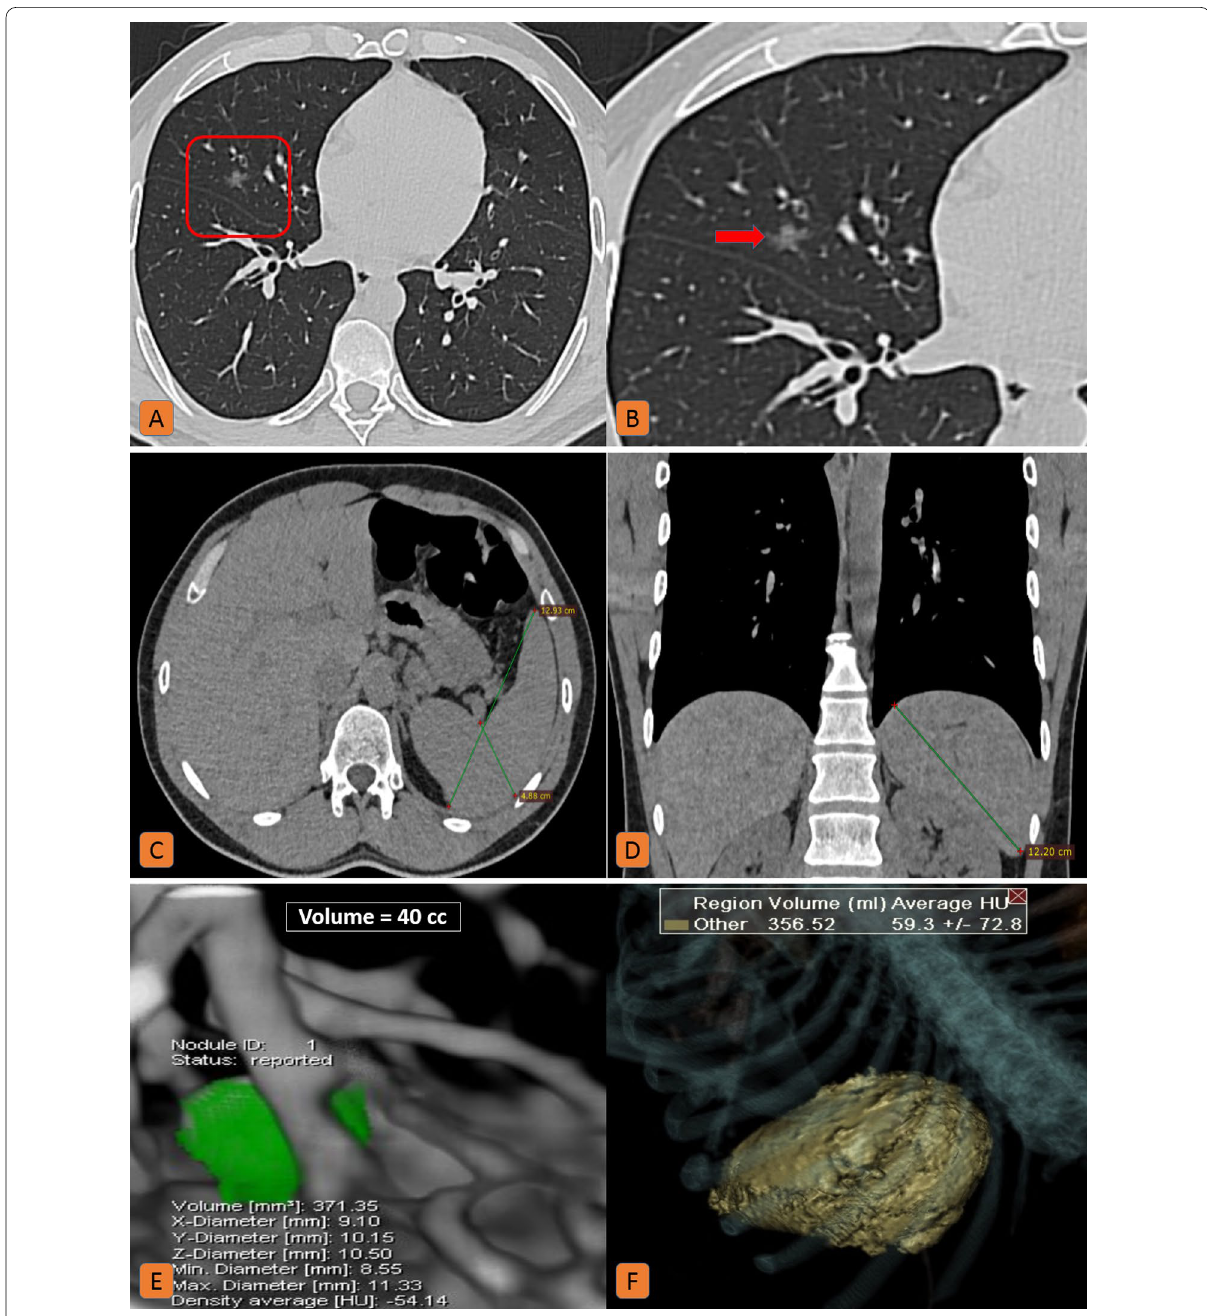
Fig. 2 Splenomegaly in a 35-year-old male patient with mild COVID-19 infection. A Axial chest CT (lung window) and B zoomed image showed single right middle small ground-glass nodular opacity. C Axial, and D coronal CT cuts of the upper window (soft tissue window) showed splenic 2D diameters (13 4.6 12.4 cm) (anteroposterior diameter x side to side thickness x craniocaudal diameter). E Lung volumetric CT assessment × × revealed a 40 cc lung nodule. F CT volumetry of the spleen was 356